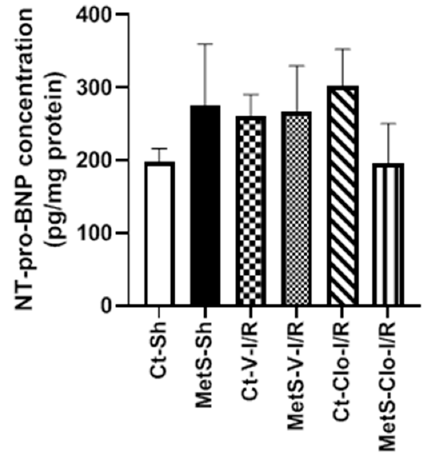
Figure 6. Tissue levels of N-terminal pro-B-type natriuretic peptide (NT-proBNP) in control and metabolic syndrome rats subjected to ischemia/reperfusion damage and pre-treated with clofibrate. Values are mean ± SEM. N = 5 per group; Abbreviations: Ct = control; MetS = metabolic syndrome; Sh = sham-operated rats; I/R: ischemic reperfusion; V = vehicle; Clo = clofibrate.